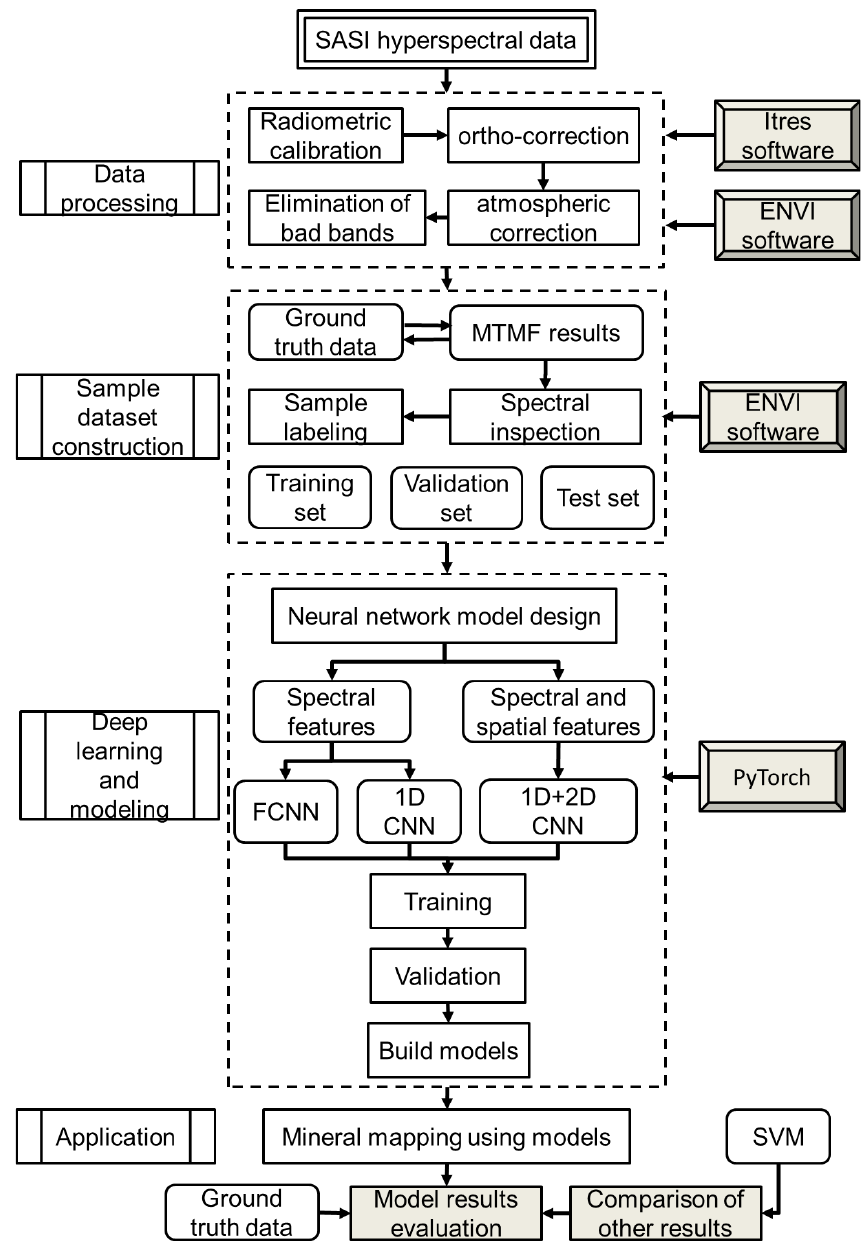
Figure 3. Workflow of the experimental process in this paper.